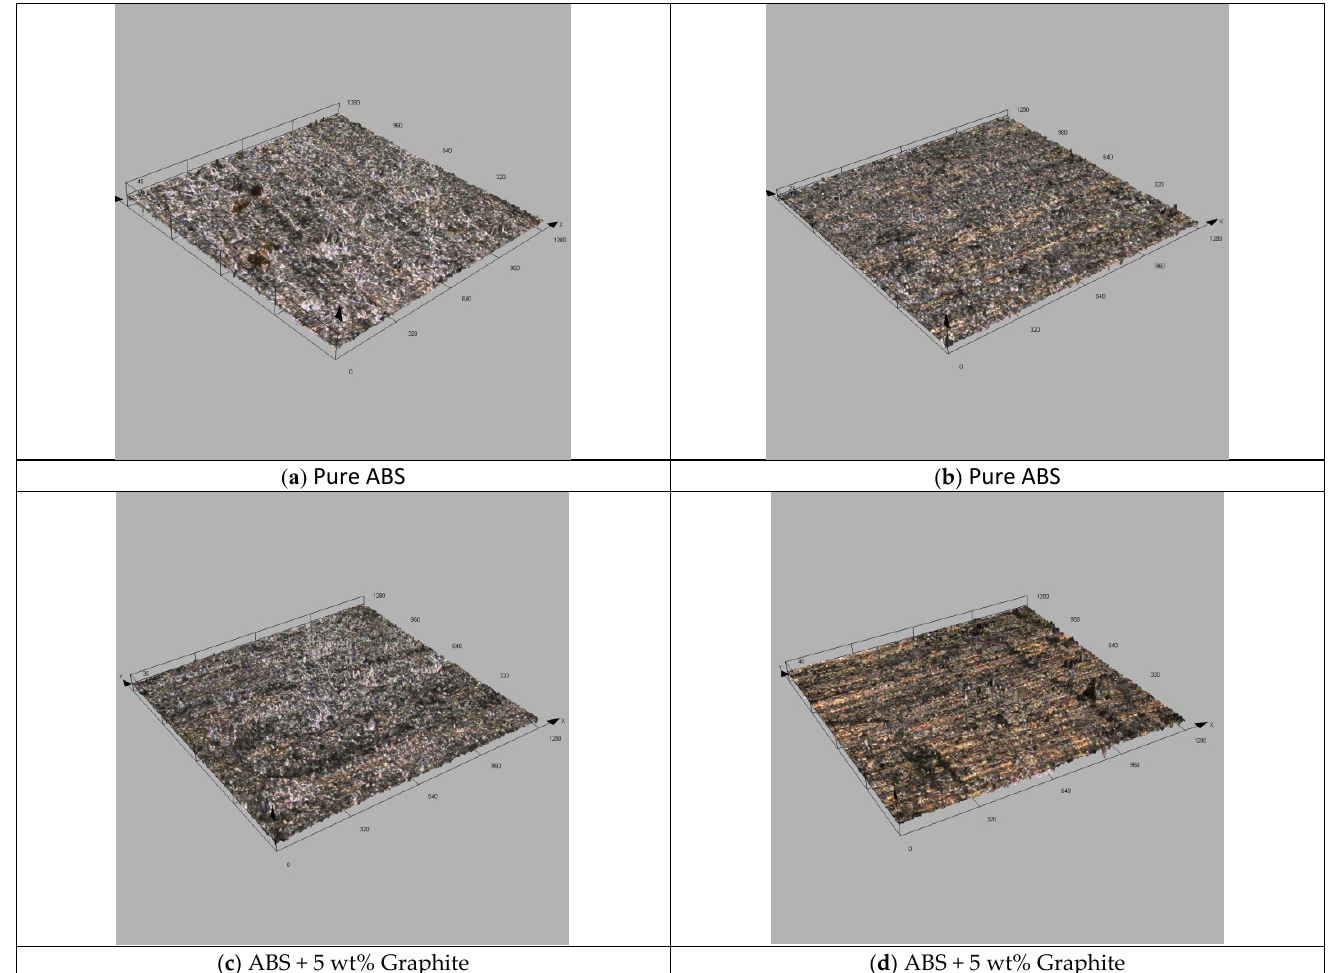
Figure 10. Three dimensional confocal images of worn-out surfaces showing the morphology of the worn-out surfaces.